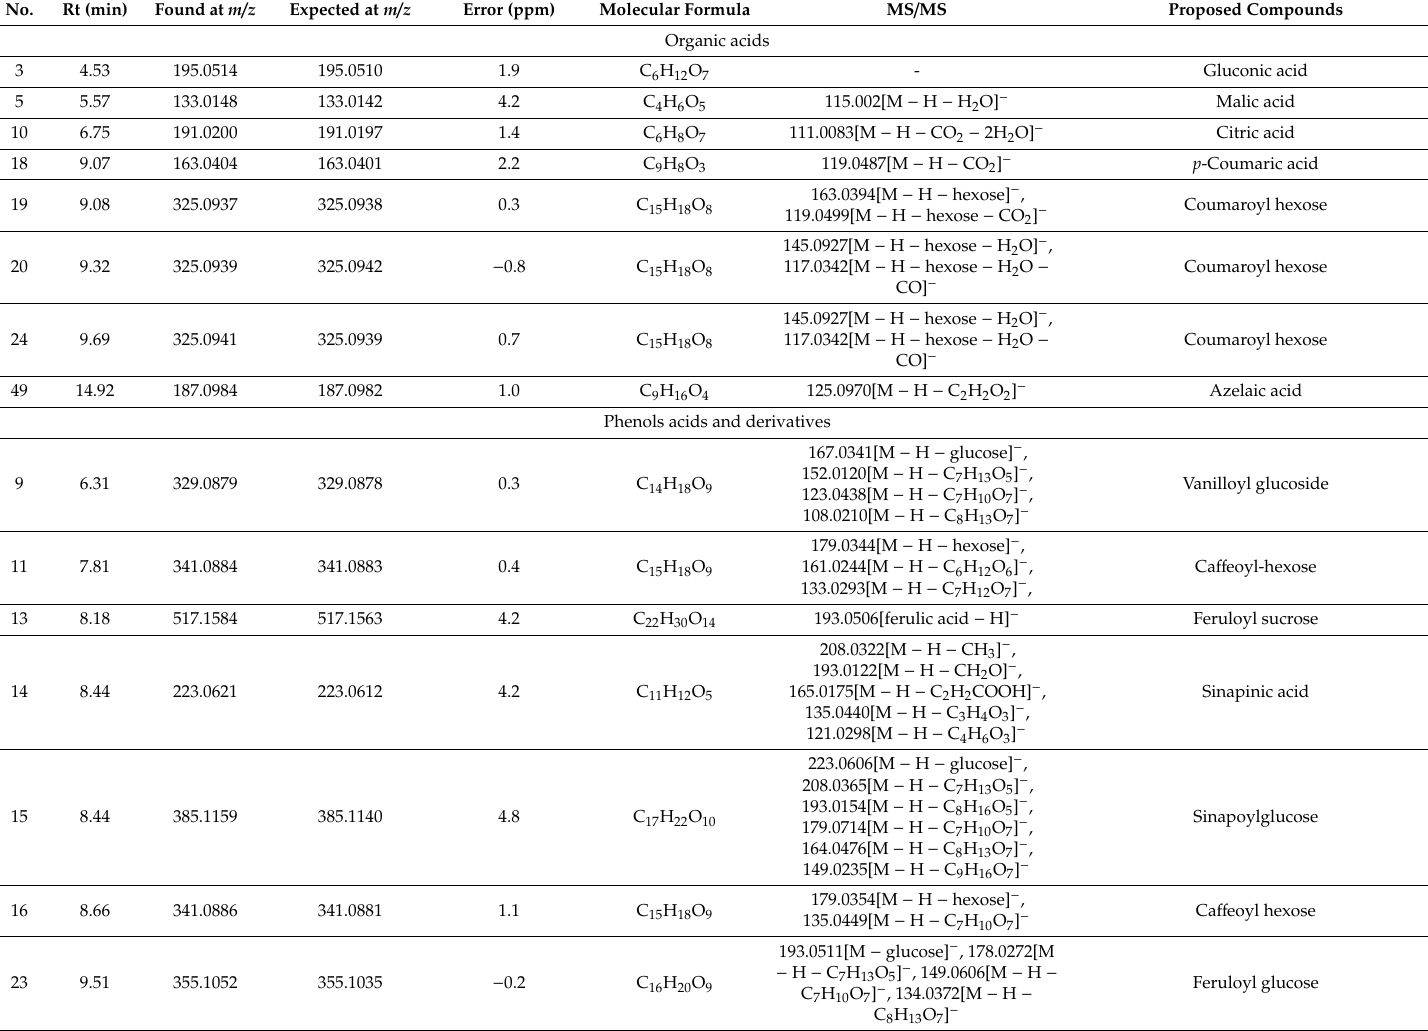
Table 3. The identified or tentatively identified compounds in 70% methanol extract of CDL by HPLC-QTOF-MS / MS under negative ion mode.